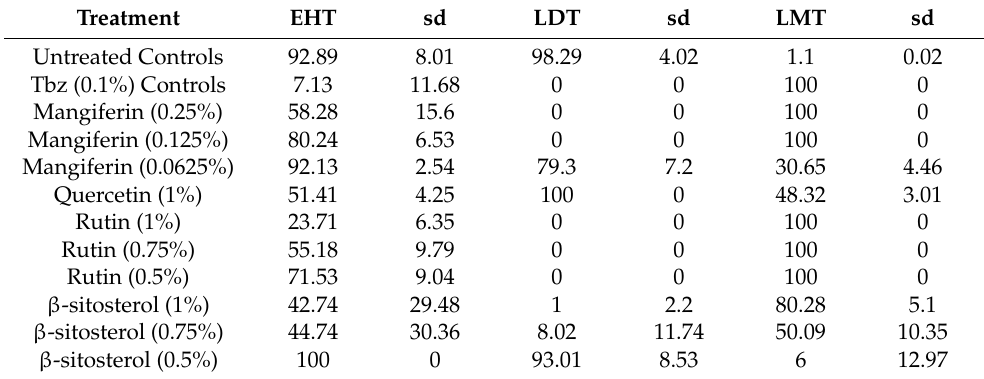
Table 1. Sheep gastrointestinal strongyle egg hatch (EHT), larval development (LDT) and larval mortality/paralysis (LMT) observed in dishes containing mangiferin (at 0.25%, 0.125% and 0.0625%), rutin (at 1%, 0.75%, 0.5%), quercetin (at 1%), and β -sitosterol (at 1%, 0.75%, 0.5%) compared to untreated and treated (0.1% thiabendazole, TBZ) controls. Data are presented as percentages. Treatment